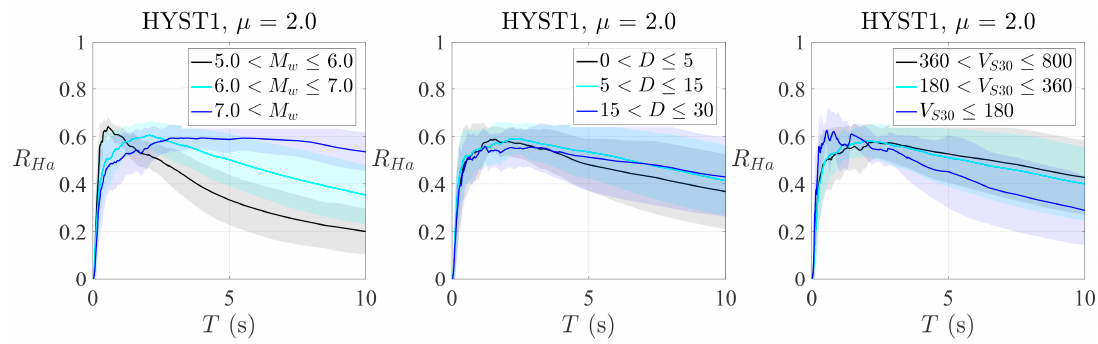
Figure 6. Spectra of the hysteretic energy reduction factor R Ha for the hysteretic model HYST1 and ductility level μ equal to 2 considering different subsets of seismic records (filled area: envelope of the spectra; solid line: mean spectrum).